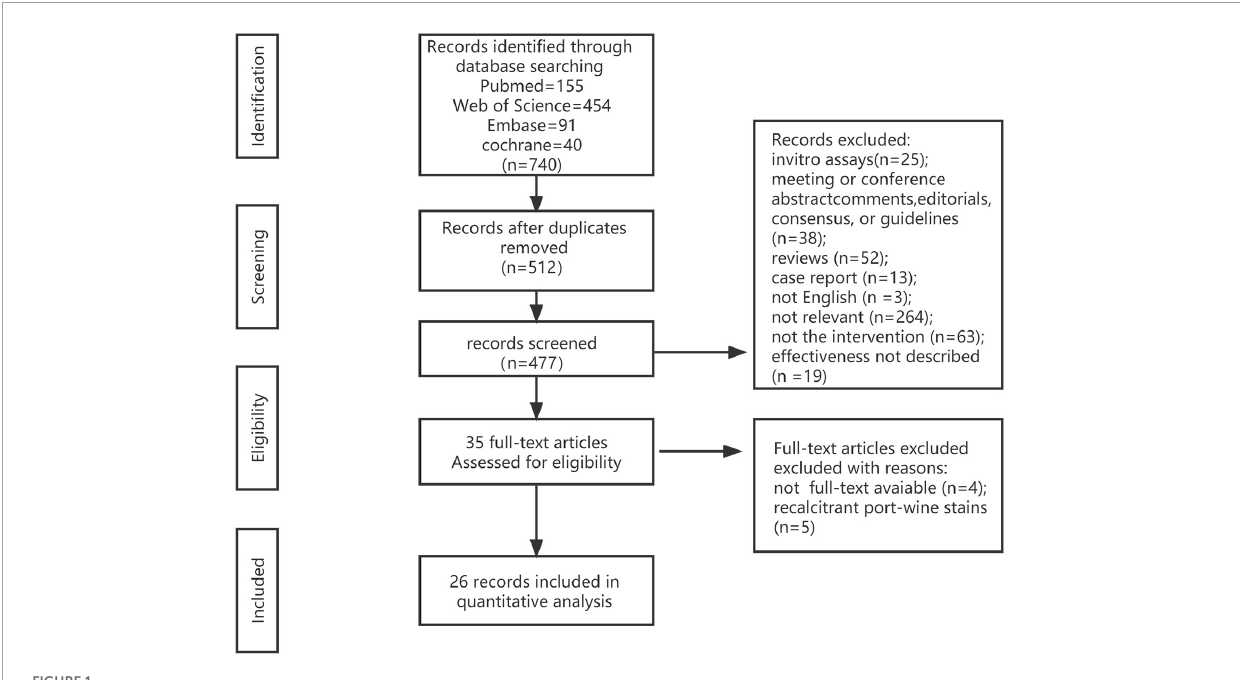
FIGURE1 Flow chart for study